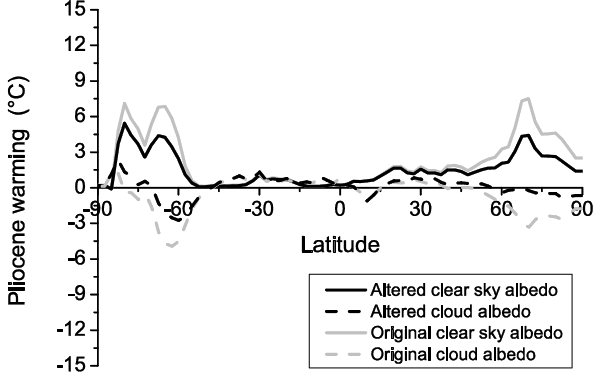
Fig. 2. Comparison of the impact on Pliocene warming of the com- ponents of planetary albedo under different formulations for the HadCM3 model. The grey lines are the formulations presented in this Sect. 5, while the black lines represent an altered calculation of the albedo components approximating the impact of clouds us- ing the difference between the incoming radiation at the top of the atmosphere and the modelled downward shortwave radiation at the